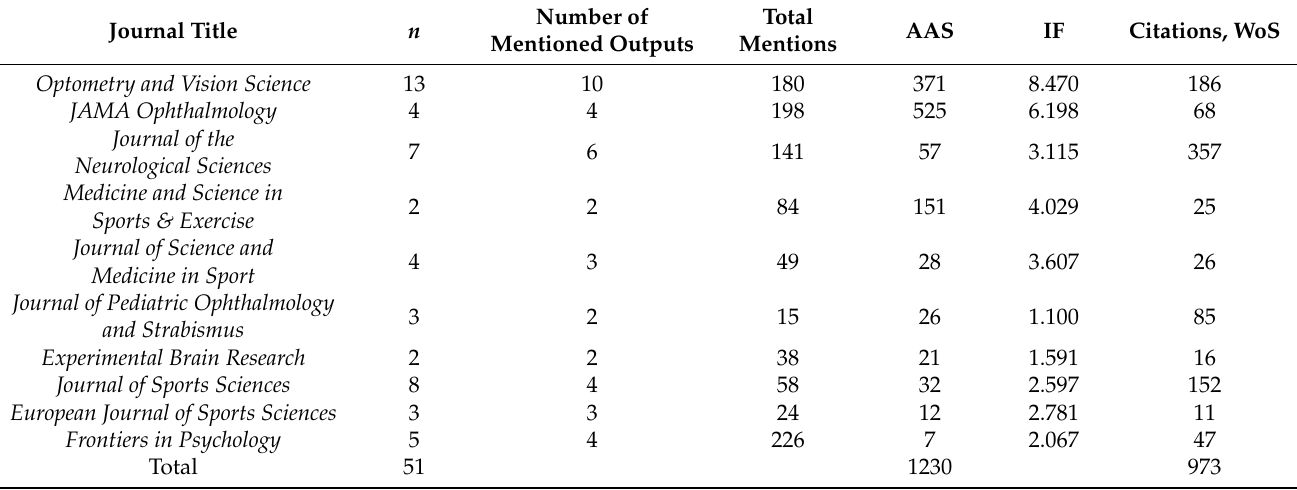
Table 3. Journals in the top 10 Altmetric Attention Score in sport vision research.